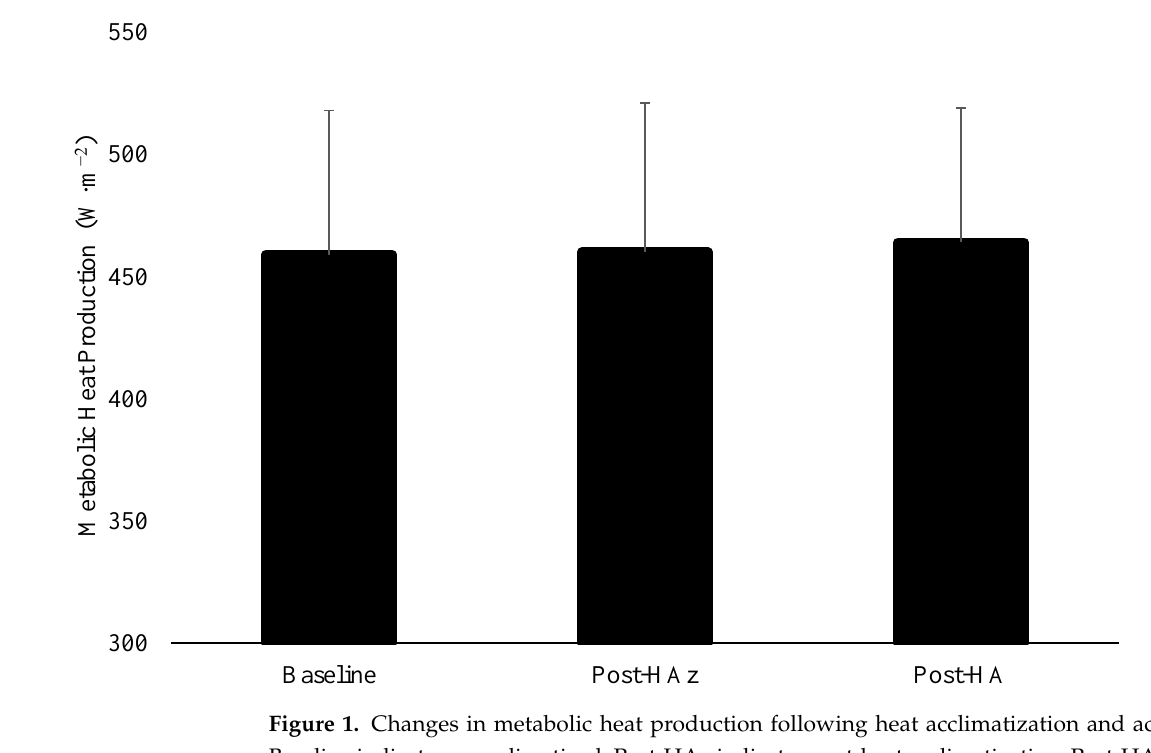
Figure 1. Changes in metabolic heat production following heat acclimatization and acclimation. Baseline indicates unacclimatized, Post-HAz indicates post-heat acclimatization, Post-HA indicates post-heat acclimation. Table 2. Metabolic heat production, evaporative heat loss, dry heat loss, running economy, rate of maximal evaporative heat loss, and total evaporation required for heat balance of male endurance athletes. Baseline indicates unacclimatized, Post-HAz indicates post-heat acclimatization, Post-HA indicates post-heat acclimation (dual heat acc). Data are presented as mean (M) ± standard deviation (SD), effect size (ES), 95% confidence intervals (95%CI). * indicates statistical significance, p ≤ 0.05.